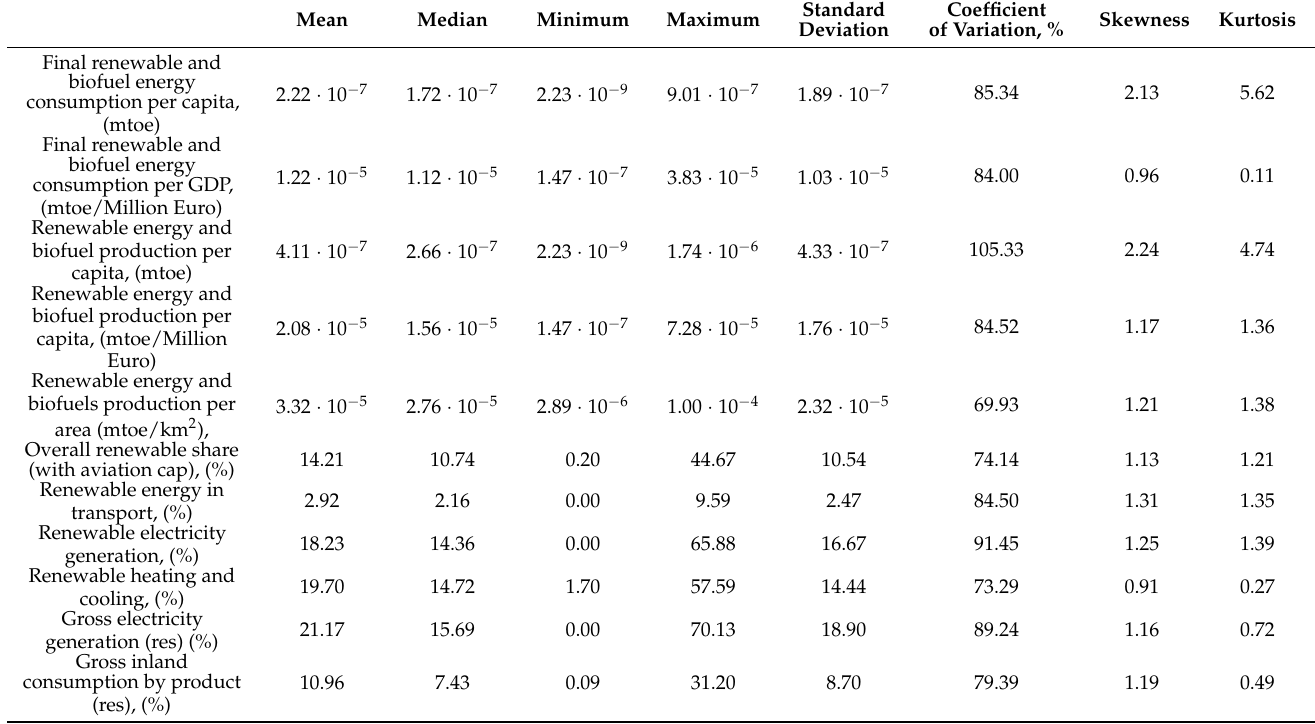
Table 2. Selected statistical indicator parameters describing RES development in the EU countries in 2008.